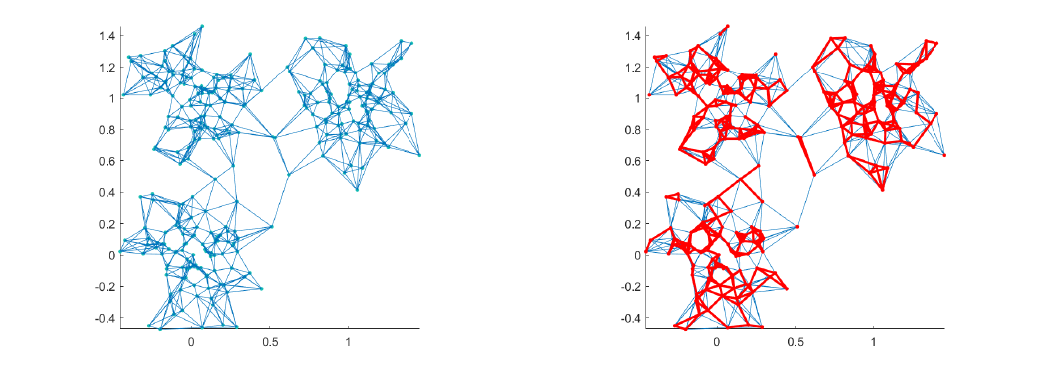
Figure 2. Illustration of the MNN graph modification on a 2D dataset with K = 11. Left: data samples and edges of initial graph; right: resulting MNN edges (red